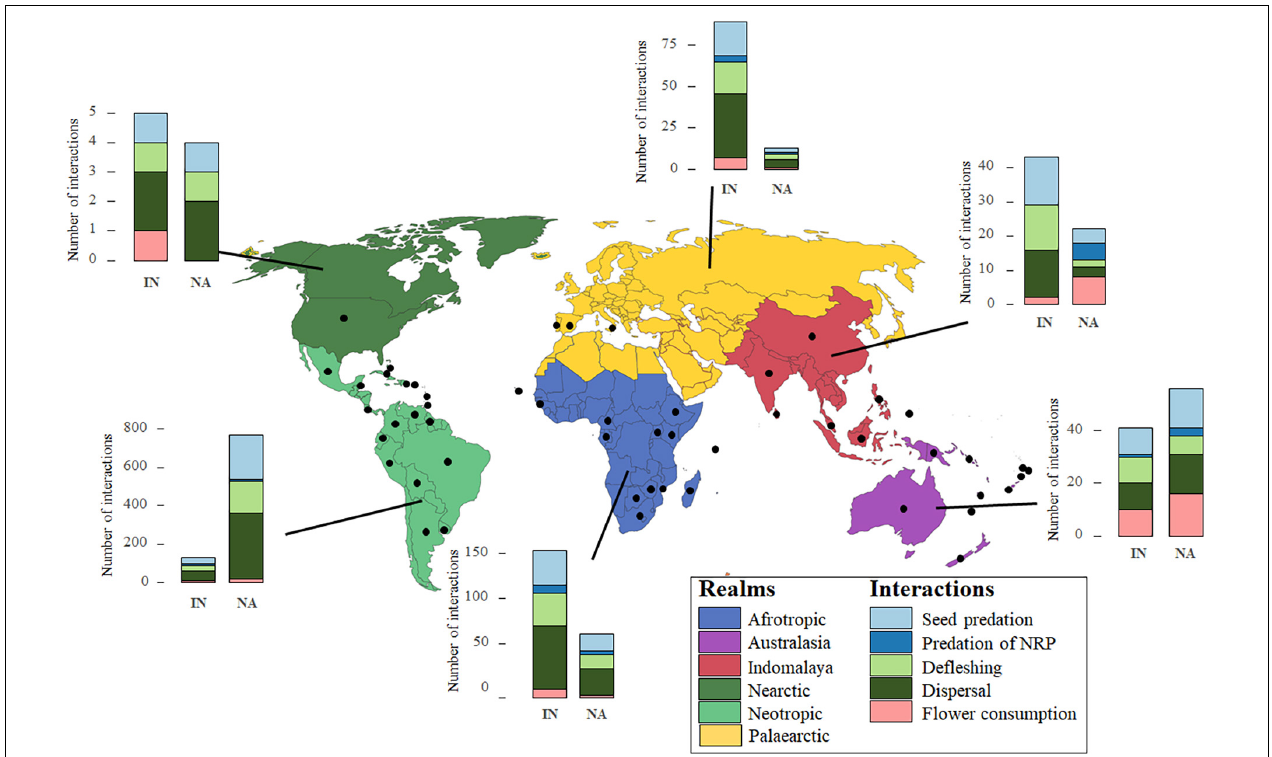
FIGURE 1 | Number of interactions between parrots and palms across the main biogeographic realms of the world (Olson et al., 2001), considering whether the palm species was in its native (NA) or introduced (IN) range. Black points show the country of parrot-palm interactions. NRP: non-reproductive parts (bark, leaves, etc.).